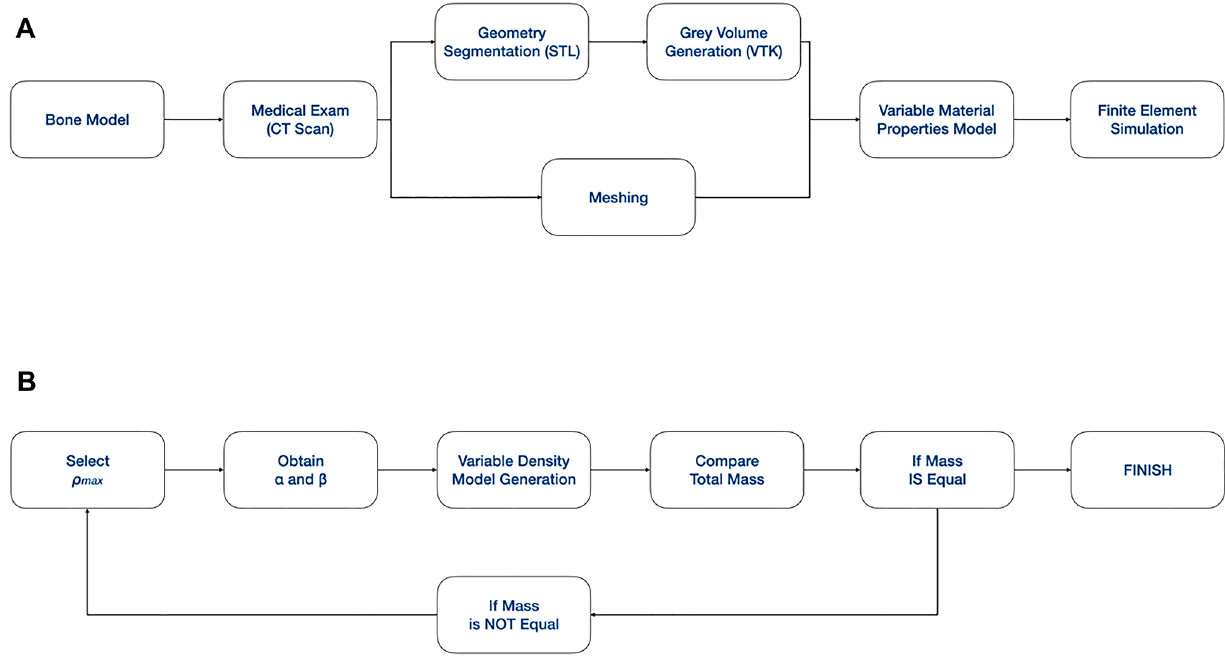
Fig. 2 a Step sequence for model generation b calibration procedure